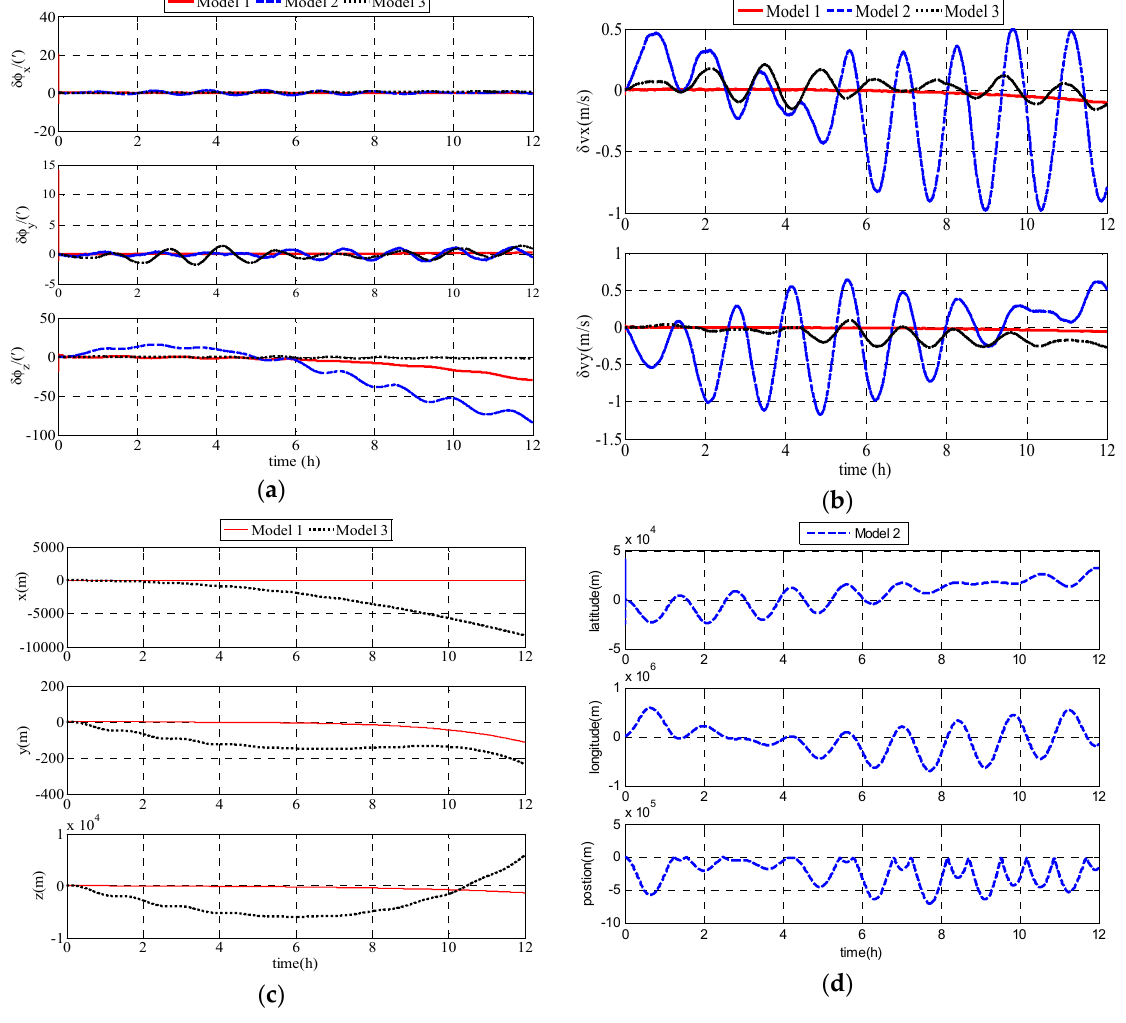
Figure 8. Experimental results: ( a ) attitude errors of the UUV; ( b ) velocity errors of the UUV; ( c ) position errors of Model 1; and ( d ) position errors of Model 2.